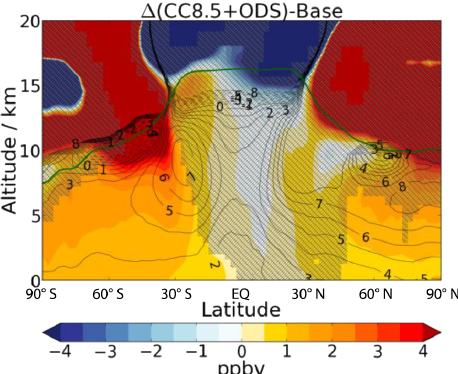
Figure 11. As for Fig. 3, but showing the change in O 3 S (ppbv, contours) from Base to (cid:49) (CC8.5 + ODS) as well as the deviation from additivity (shading) of the response. Areas where the shading is not significant at the 95% level according to a two-tailed Stu- dent’s t test are hatched out. The solid green line indicates the ther- mal tropopause of the Base